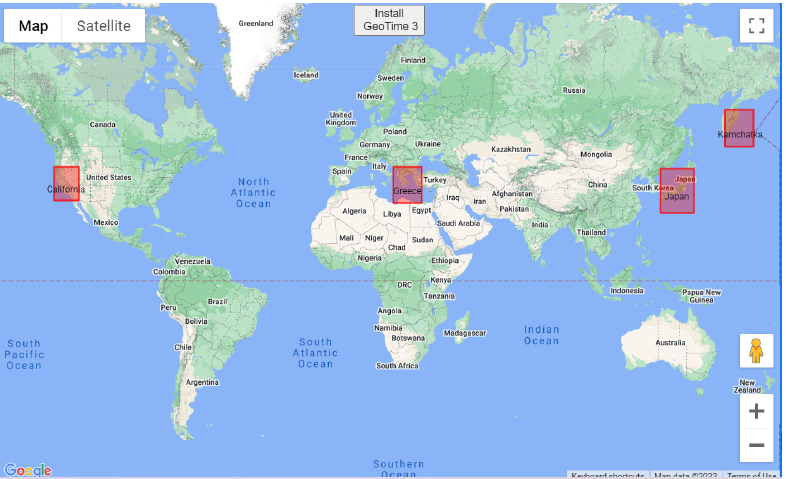
Figure 2. Starting page of the platform displaying the available regions for selection, including California, the Eastern Mediterranean, Japan, and Kamchatka. The option to download GIS GeoTime is also available by “Install GeoTime 3”